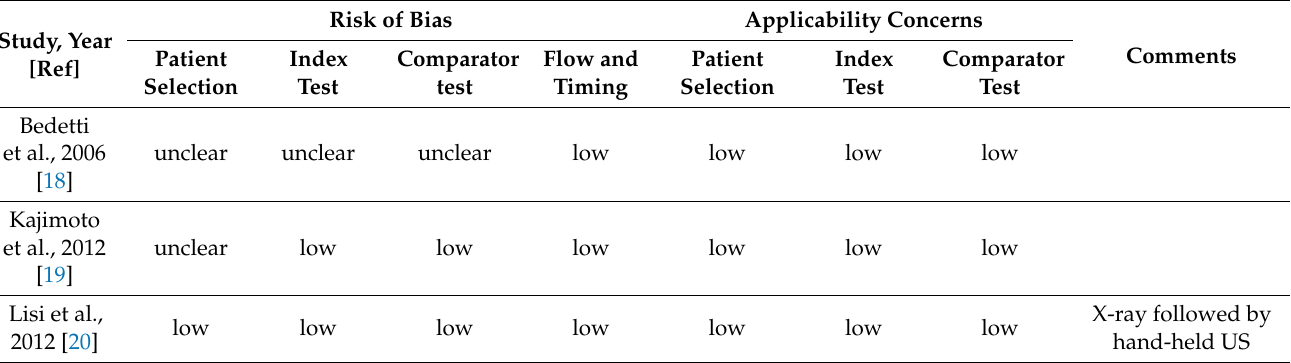
Table 3. QUADAS-2 quality assessments of evaluated